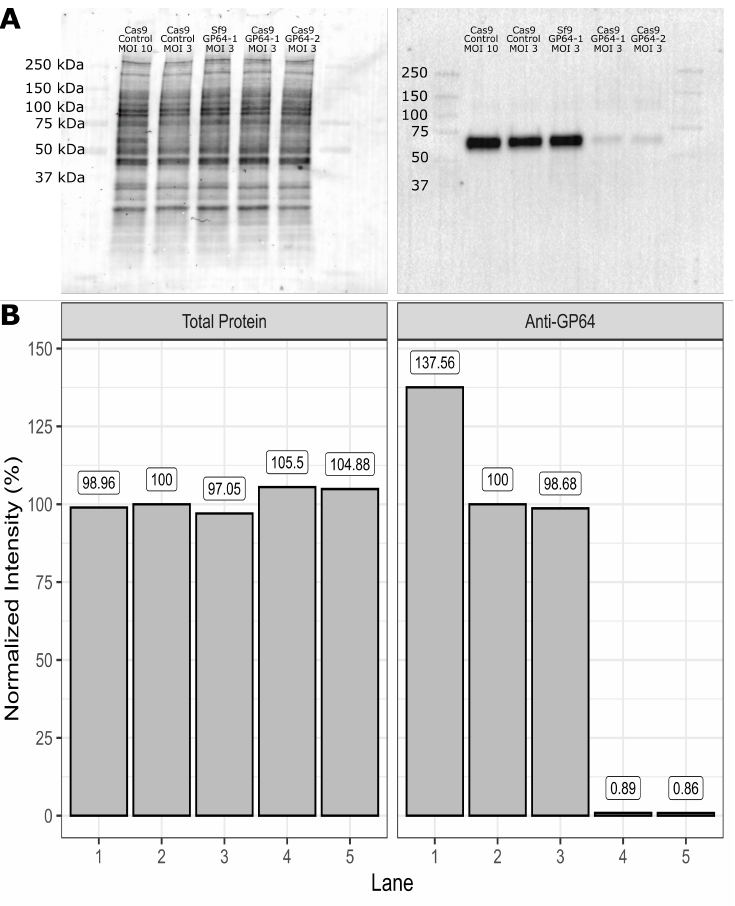
Figure 1. CRISPR-mediated disruption of gp64 is target specific. ( A ) Western blot of infected cell lysates with AcV5 anti-GP64 antibody. Left panel: total protein on PVDF membrane after transfer from SDS-PAGE gel. Right panel: PVDF membrane after probing with anti-GP64 AcV5 monoclonal antibody revealed intense bands corresponding to the ˜64 kDa GP64 protein in lanes 1–3, and very faint bands in lanes 4 and 5. ( B ) Semi-quantitative western blot analysis of GP64 abundance in infected cell lysates. Left panel: Normalized intensity of total protein in each lane of PVDF membrane from A. Lane 2 was selected as the reference for total protein normalization. Right panel: Relative abundance of GP64 determined using total protein normalization. The columns 1–5 in B correspond to the labeled lanes in A. All samples were taken at 48